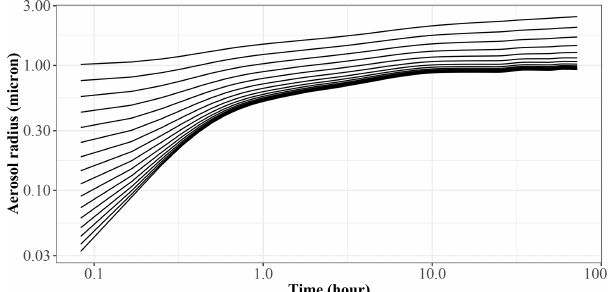
Figure 6. Time series plot of size bins for experiment A1 with the high-RH